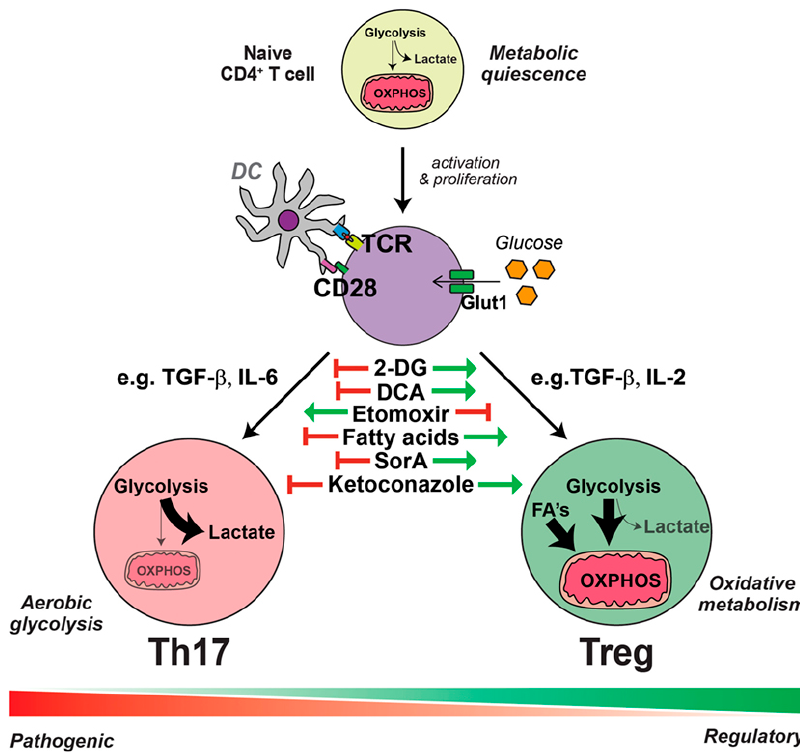
Figure 2. Metabolic requirements of Th17 and Treg responses. Th17 cells are dependent on aerobic